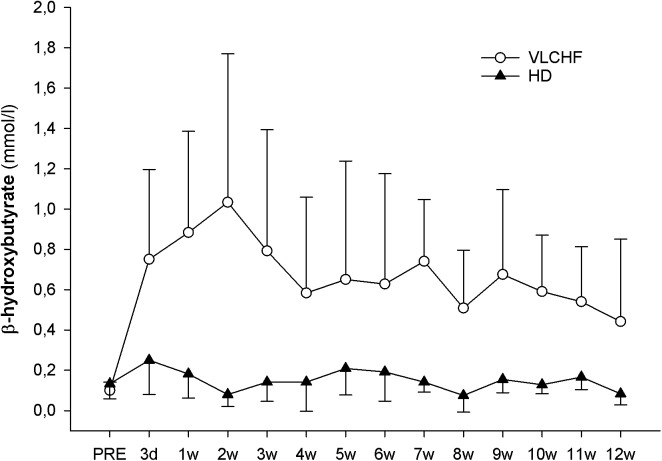
Capillary β-hydroxybutyrate concentrations.